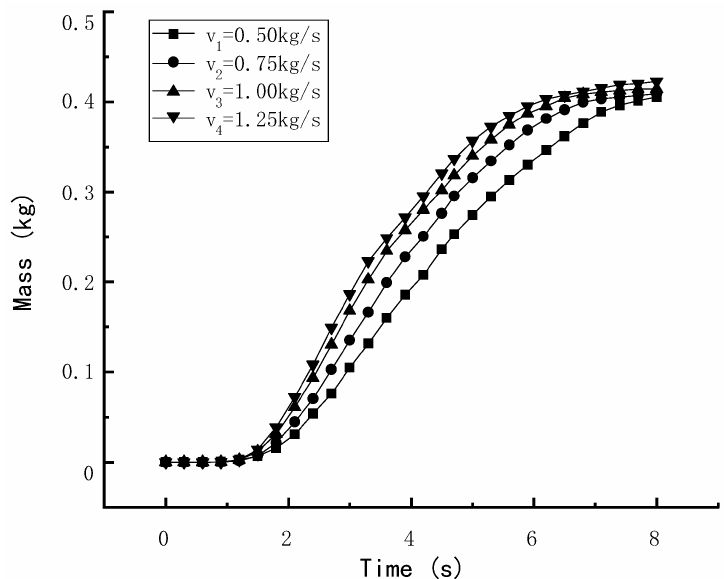
Figure 7. Curves of quality change of rice filling at different feeding